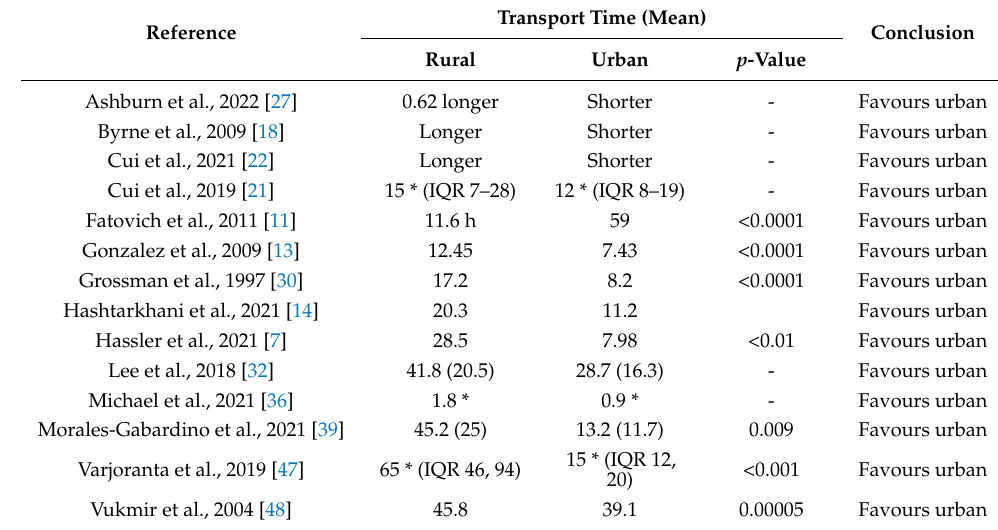
Table 3. Differences between rural and urban areas regarding transport